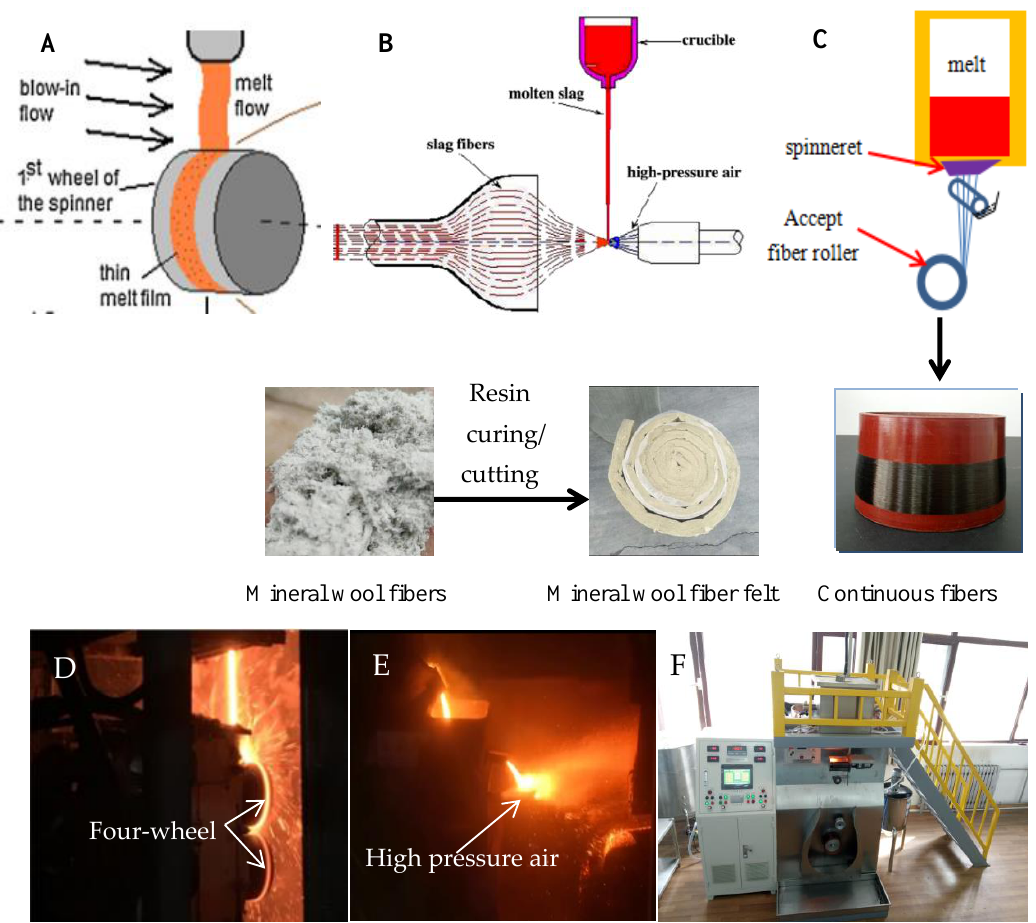
Figure 2. Schematic diagram of fiber production. ( A ) Rotating centrifugation (Chan et al., 2017). ( B ) Air blowing (Wang et al., 2010). ( C ) Spinneret drawing. ( D ) The production site of rotating centrifugation (Zhao et al., 2018). ( E ) The production site of air blowing. ( F ) The production site of continuous fibers.